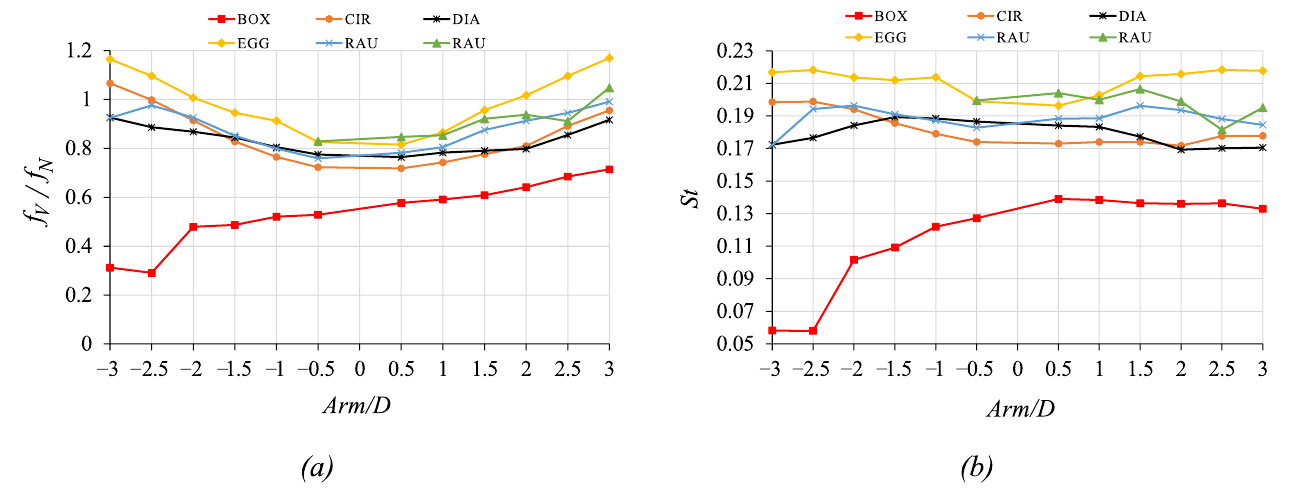
Figure 9. ( a ) The frequency ratio verses the arm ratio for each cross section. ( b ) The Strouhal number versus the arm ratio for each cross section. Here, negative Arm / D represents a pivot point at the downstream of the cross section and positive Arm / D represents a pivot point at the upstream side of the cross